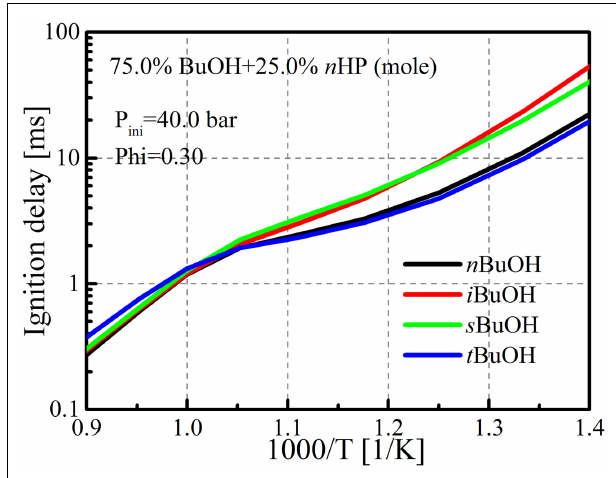
FIGURE 2 | Comparison of ignition delays among various butanol/ n -heptane mixtures . Seventy-five percent butanol and 25% n -heptane (mole